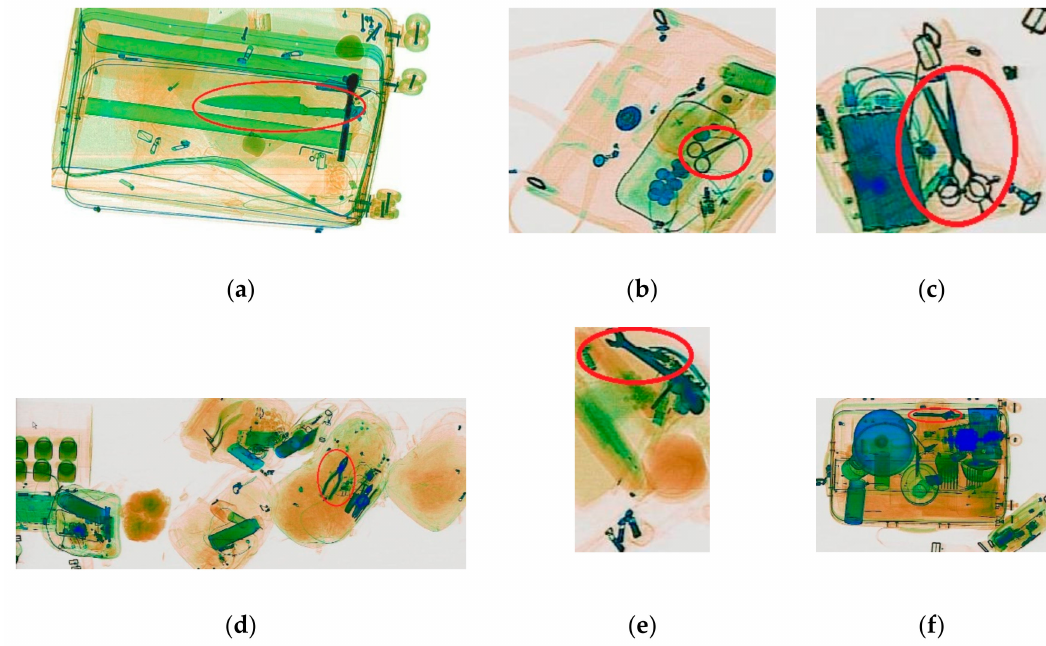
Figure 5. Mislabeled negative samples. Images are incorrectly labeled negatives despite containing ( a ) knife, ( b ) scissors, ( c ) scissors, ( d ) pliers, ( e ) wrench, and ( f )